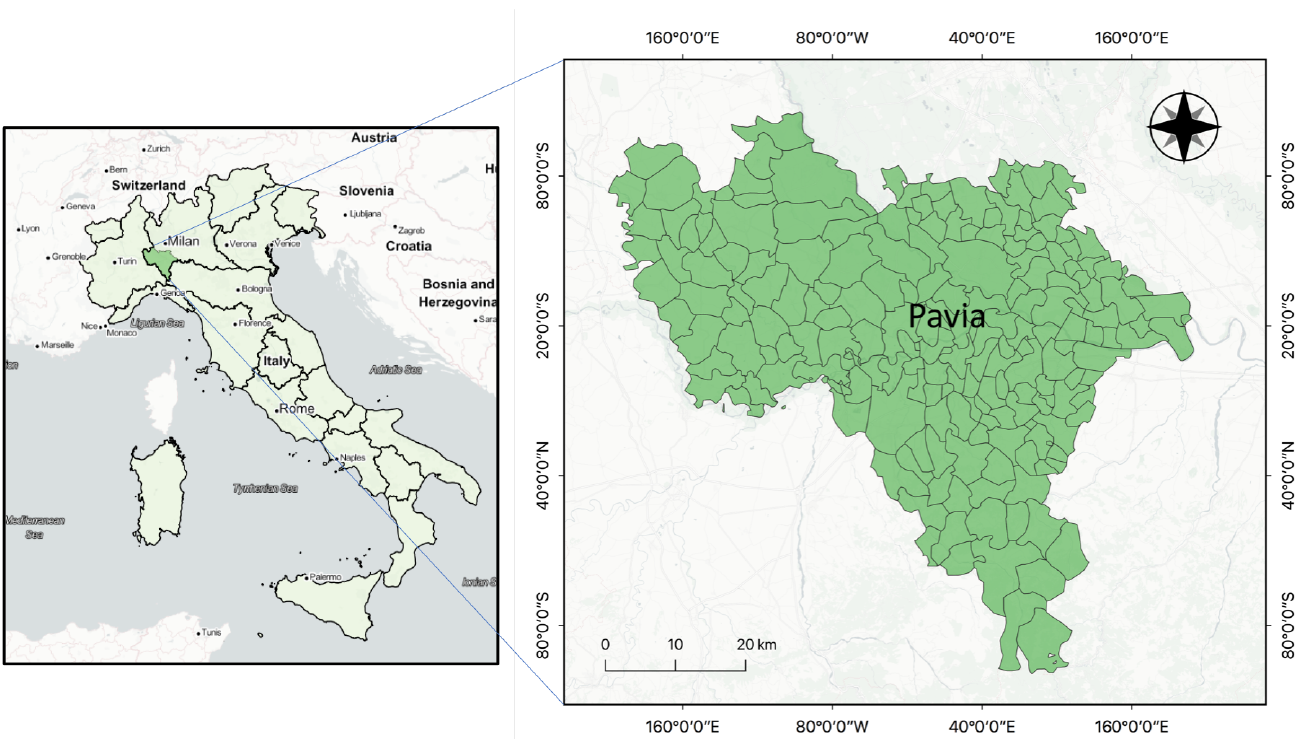
Figure 1. Map of the province of Pavia,